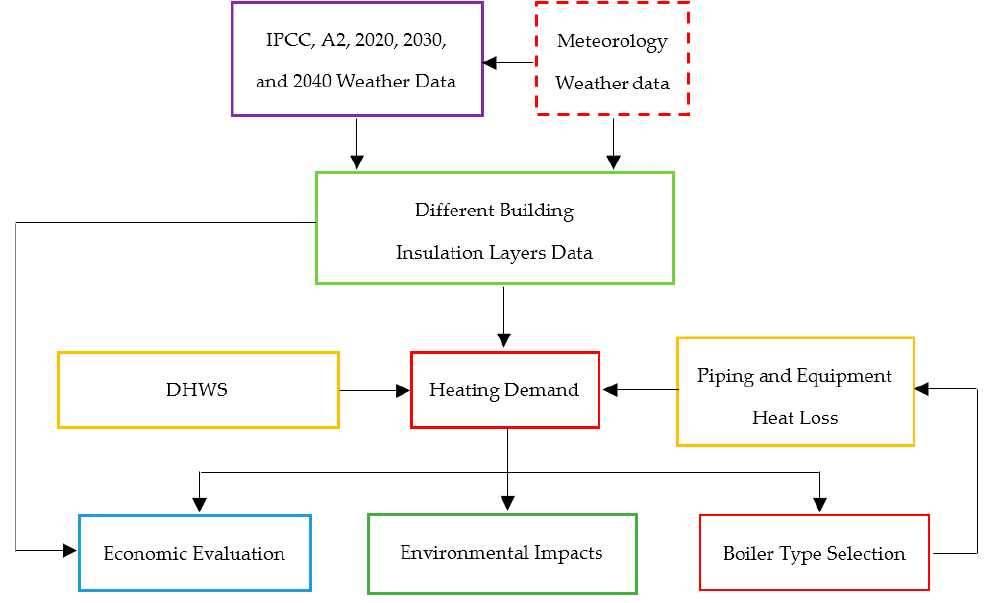
Figure 10. Schematic flowchart for evaluating different retrofit scenarios.